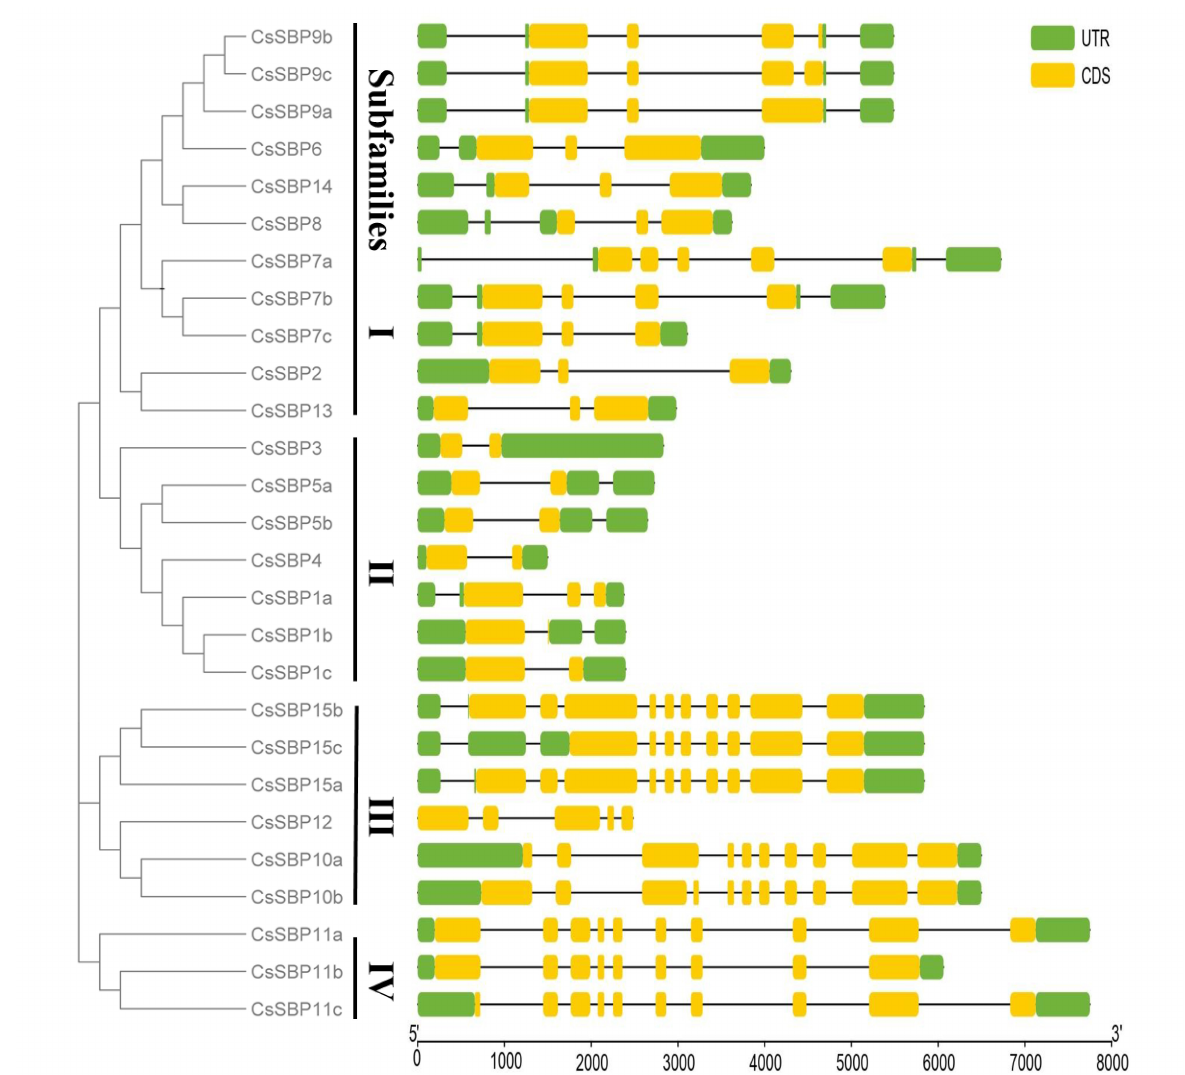
Figure 6. Gene structure of sweet orange CsSBP genes. Exons, introns, and untranslated region (UTR) are indicated by yellow rounded rectangles, black lines, and green rounded rectangles, respectively. The scale bar at the bottom is used to estimate the sizes of protein structure and gene